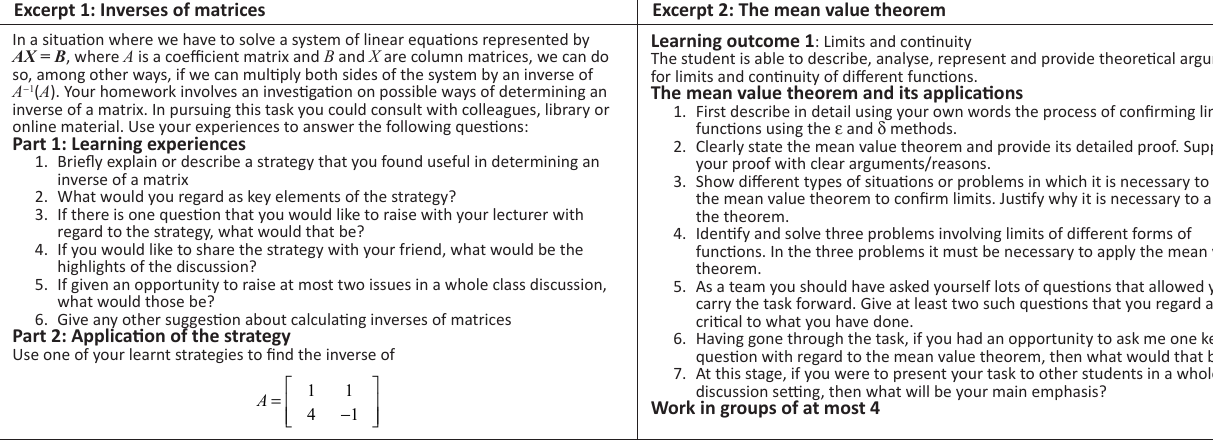
FIGURE 3: Kwena’s two teaching